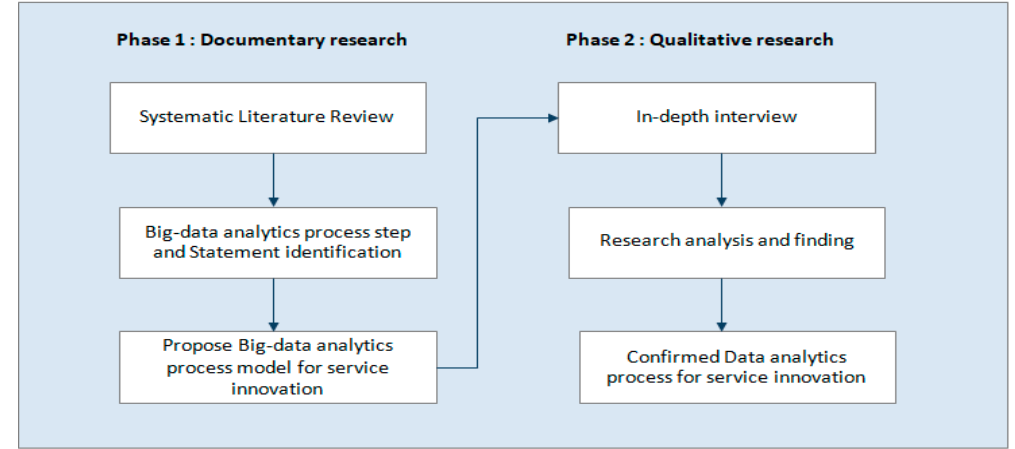
Figure 2. Research process. Source: Developed research framework by authors.